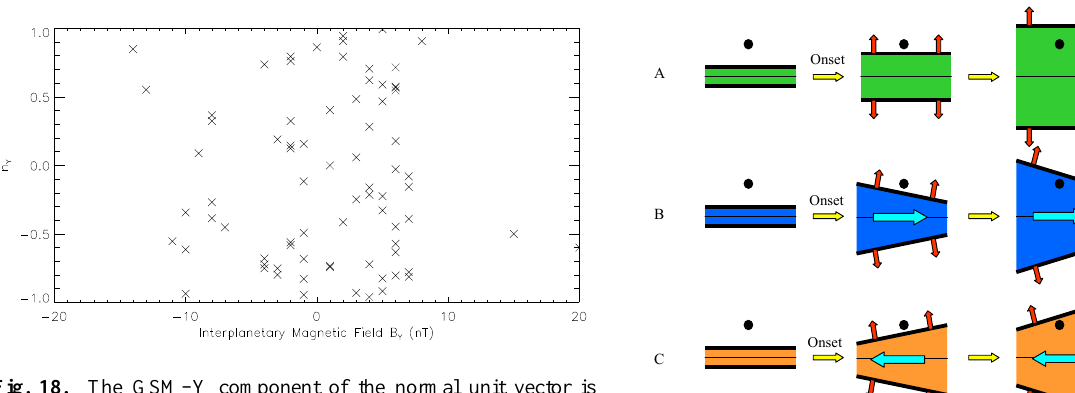
Fig. 18. The GSM–Y component of the normal unit vector is compared to the IMF–Y (GSM) component to test for correlation. Lagged magnetic field data from ACE were used to obtain the IMF–Y input. No simple relationship exists between the IMF–B Y and the normal vector of the expansion.